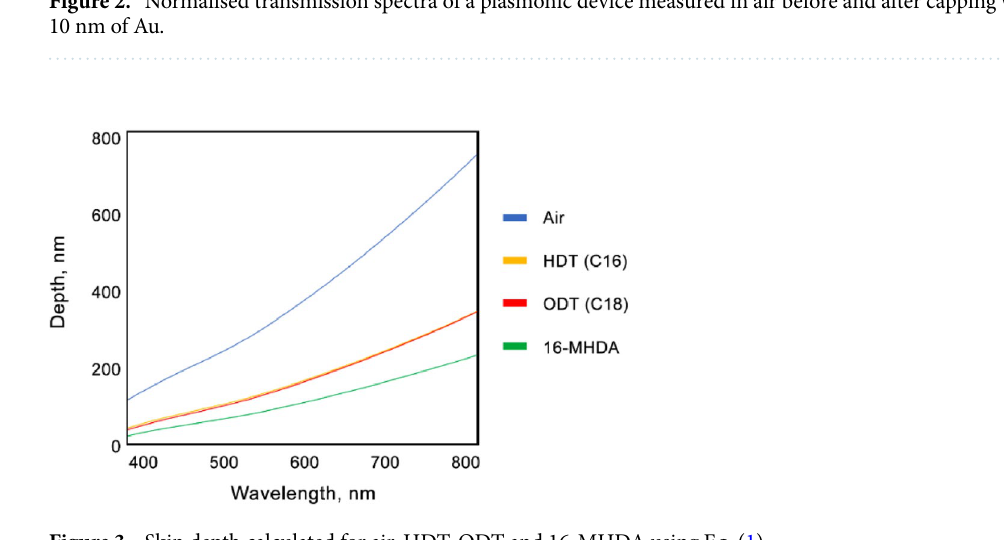
Figure 3. Skin depth calculated for air, HDT, ODT and 16-MHDA using Eq.